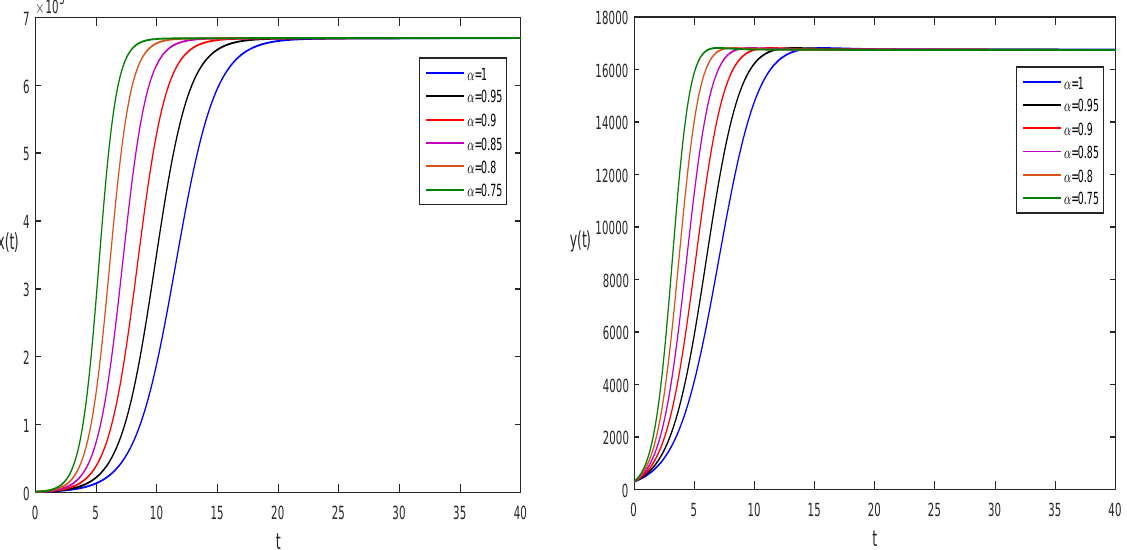
Figure 6. Unique solution of deterministic fractional model in Equation (14) for different fractional parameter